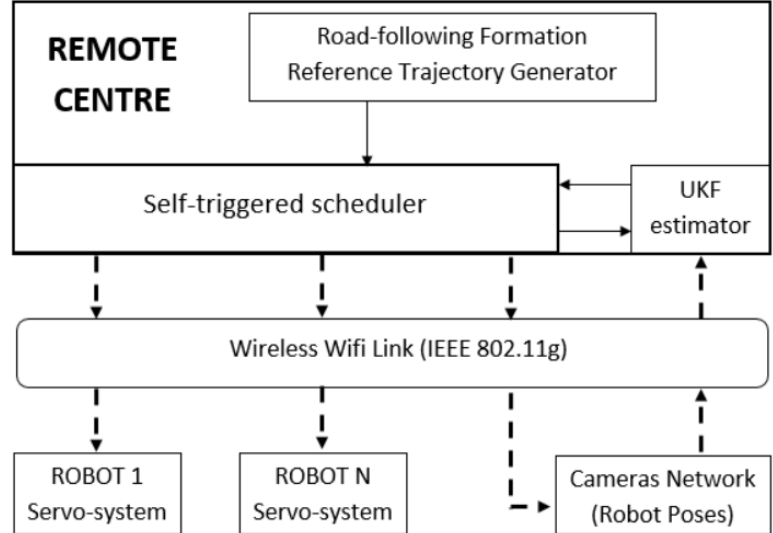
Figure 7. Description of the main elements in our implementation scenario: the remote centre, the robots formation, the camera network and the wireless communication channel. The remote centre carry out the principal tasks: reference trajectory generation of each robot according to the road-following strategy, unscented Kalman filter(UKF) and self-triggered control based on Lyapunov functions for asynchronous request of measurements and actuations on the